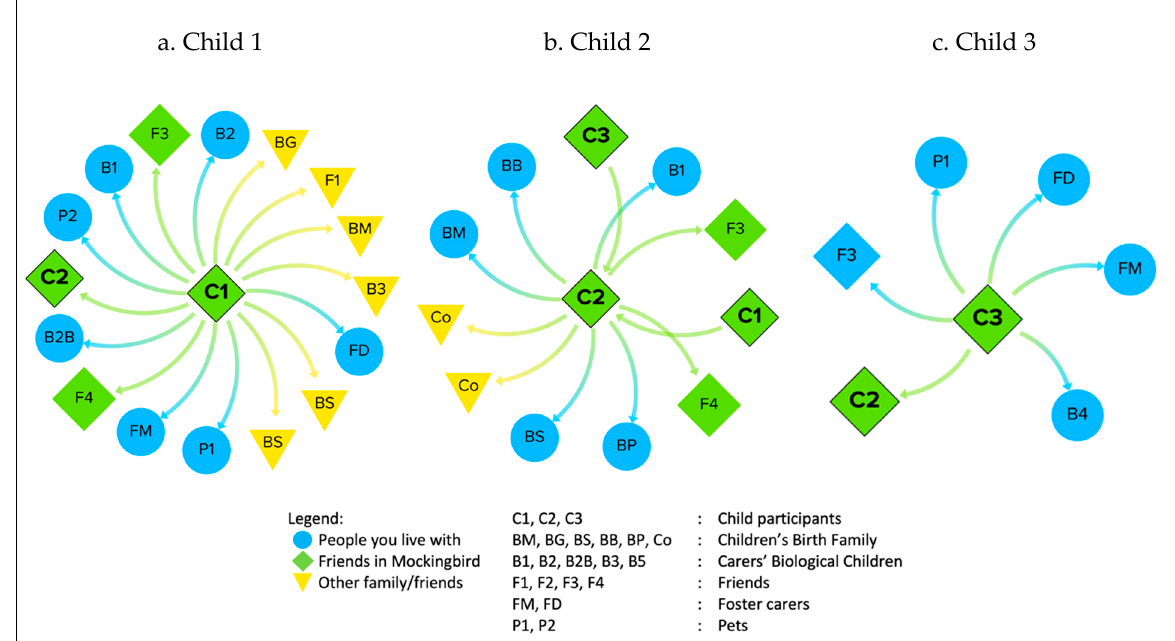
Figure 3. Individual networks for each of the three children.